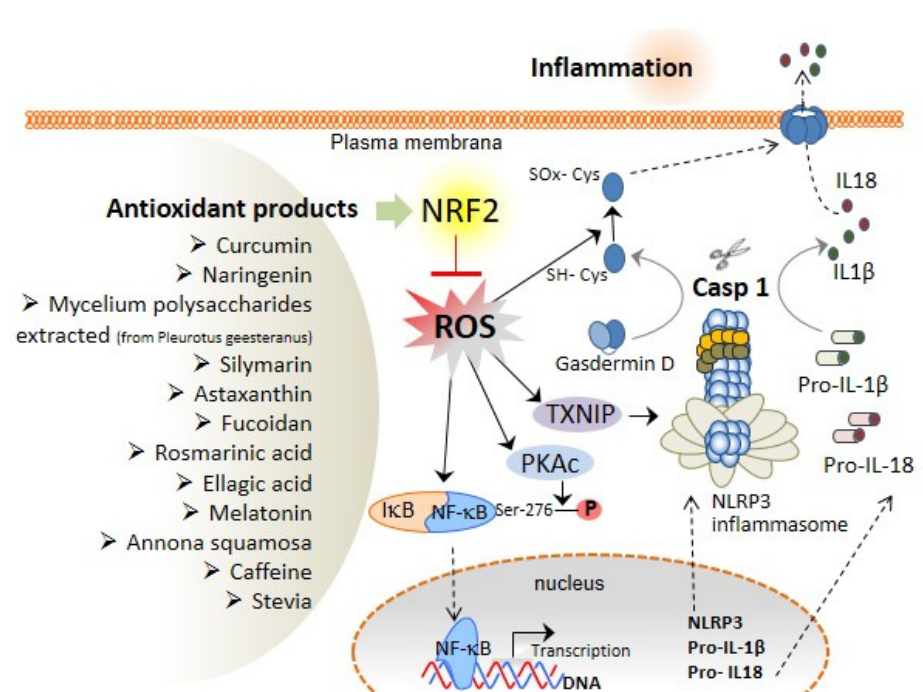
Figure 2. Role of ROS in NLRP3 inflammasome activation and liver damage. inflammasome activation and pyroptosis execution, thus inducing inflammation. Antioxidant products increase Nrf2 activity, which attenuates ROS production and prevents the oxidation of gasdermin D, TXNIP, and NF-kB. The oxidation of some amino acid residues in these compounds is needed for inflammasome activation and pyroptosis induction; consequently, antioxidant products may prevent the inflammatory response via Nrf2 activation.